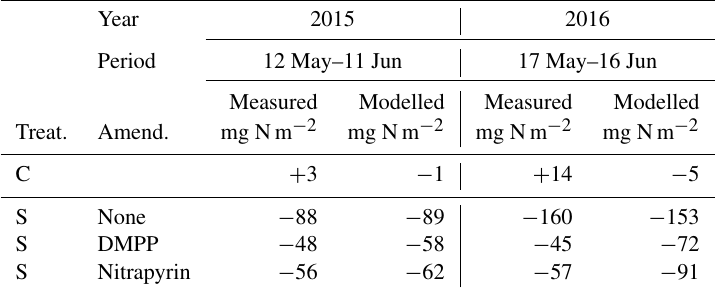
Table 5. Seasonal N 2 O emissions measured and modelled during late spring in 2015 and 2016 without slurry (C) or with slurry applied in spring (S) without NI, with nitrapyrin or with DMPP on dates in the field study (Table 3). Negative values denote emissions, and positive values denote